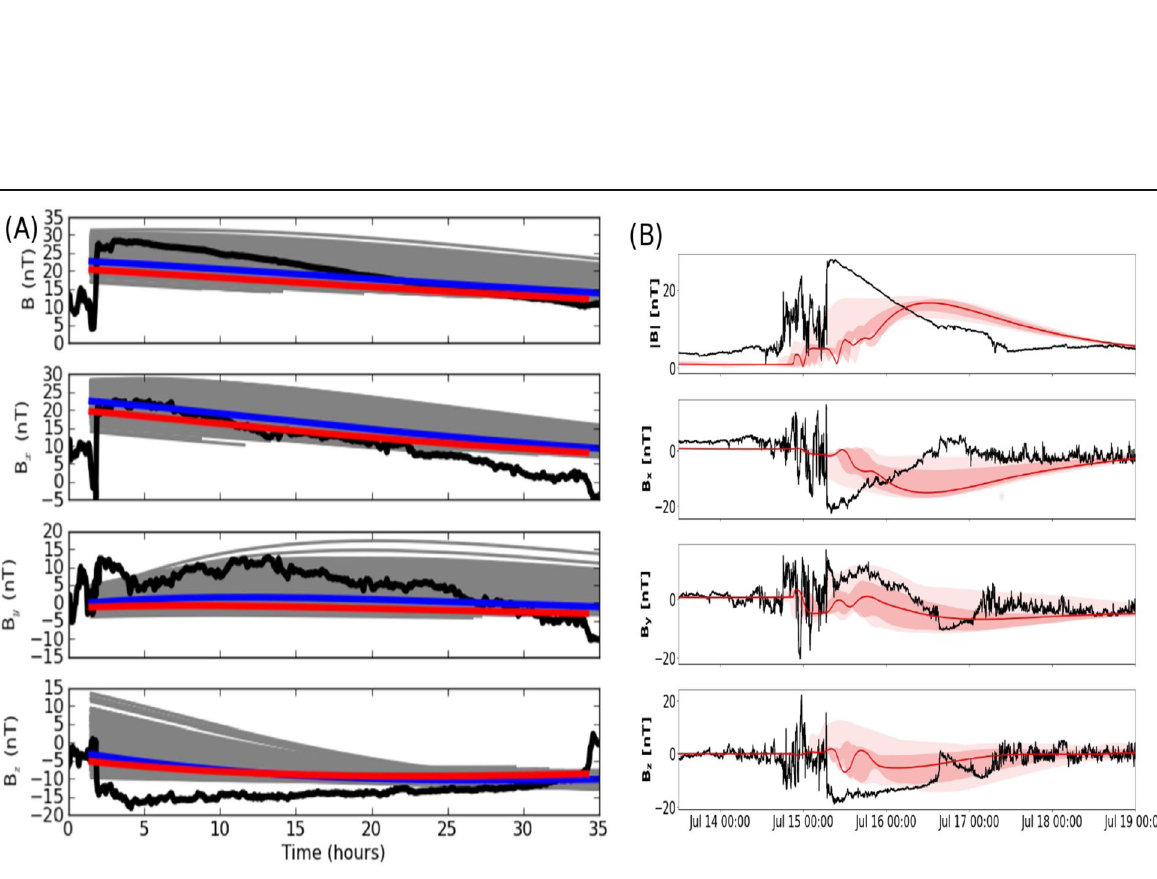
Fig. 39 Predicted (non-black curves and shaded areas) and observed (black curves) CME magnetic field profiles at 1 AU from two different models. Panel ( a ): from Kay and Gopalswamy 2018; panel ( b ): from Scolini et al. 2019b. The predicted profiles consider uncertainties in input parameters. In both panels from top to bottom the magnetic field magnitude, and its Bx, By, and Bz components in the GSE system are